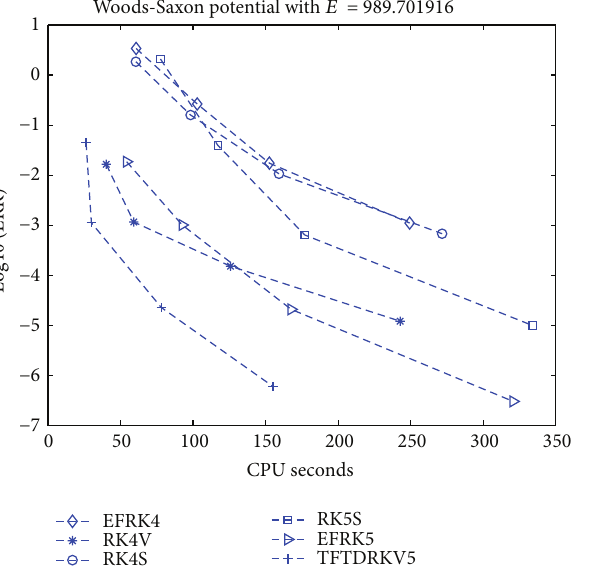
Figure 7: Efficiency curves for Problem